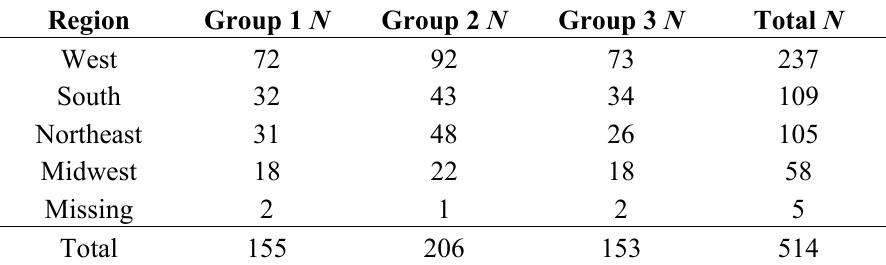
Table 3. Regional composition of study participant